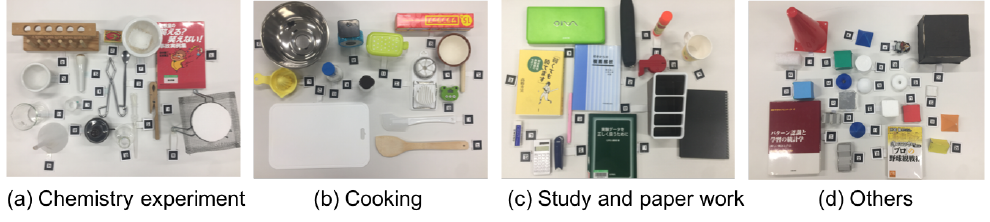
Figure 11. Four types of tabletop objects configurations.